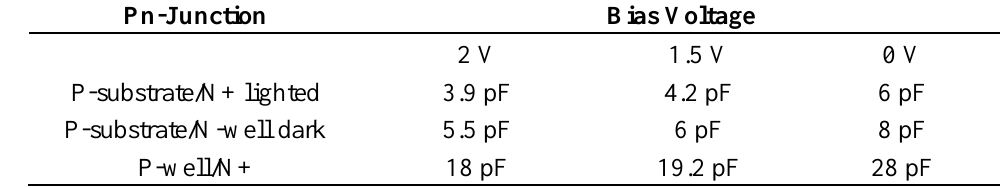
Table 1. Measured pn-junction capacitance for different bias voltages.